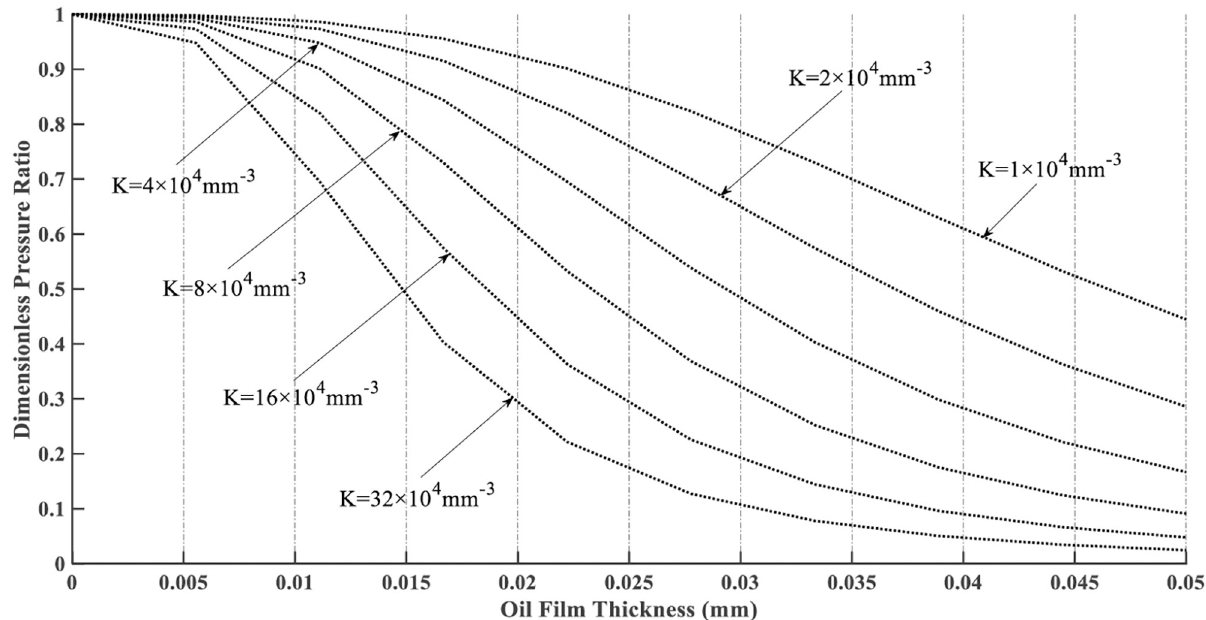
Fig 2. Working characteristic curves of the hydrostatic support.